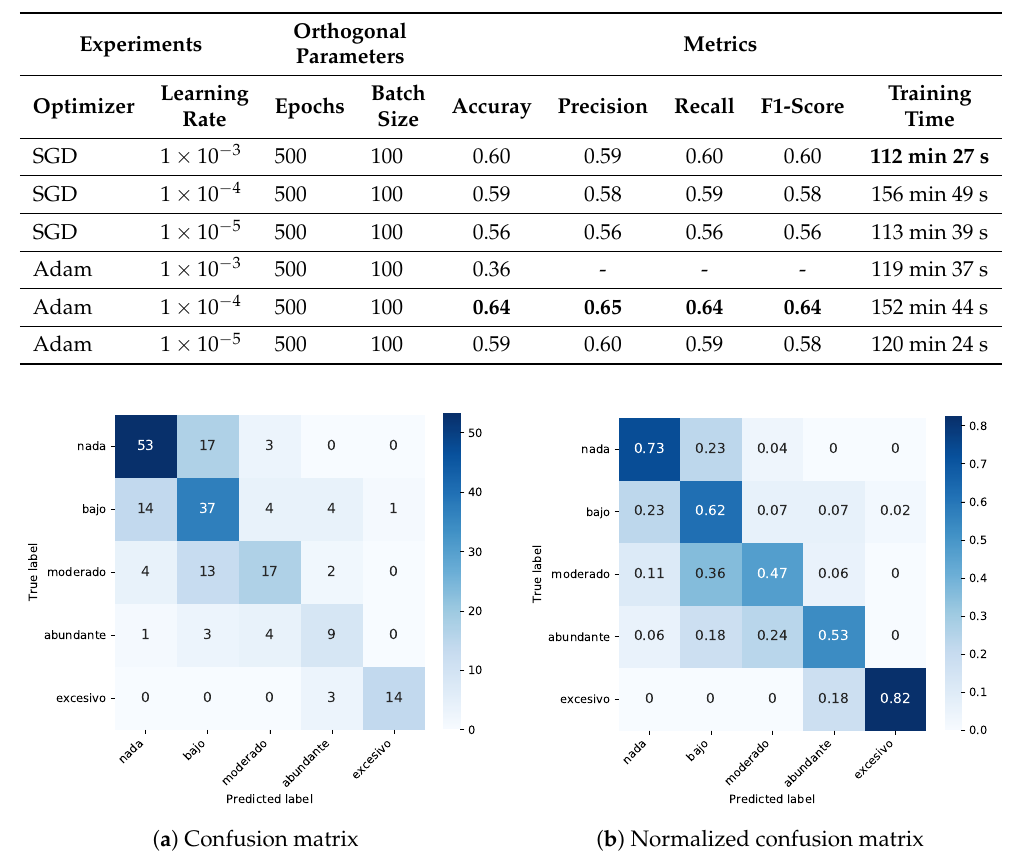
Table 3. Table of results obtained by the exploitation grid search. Time is displayed in minutes (min) plus seconds (s).